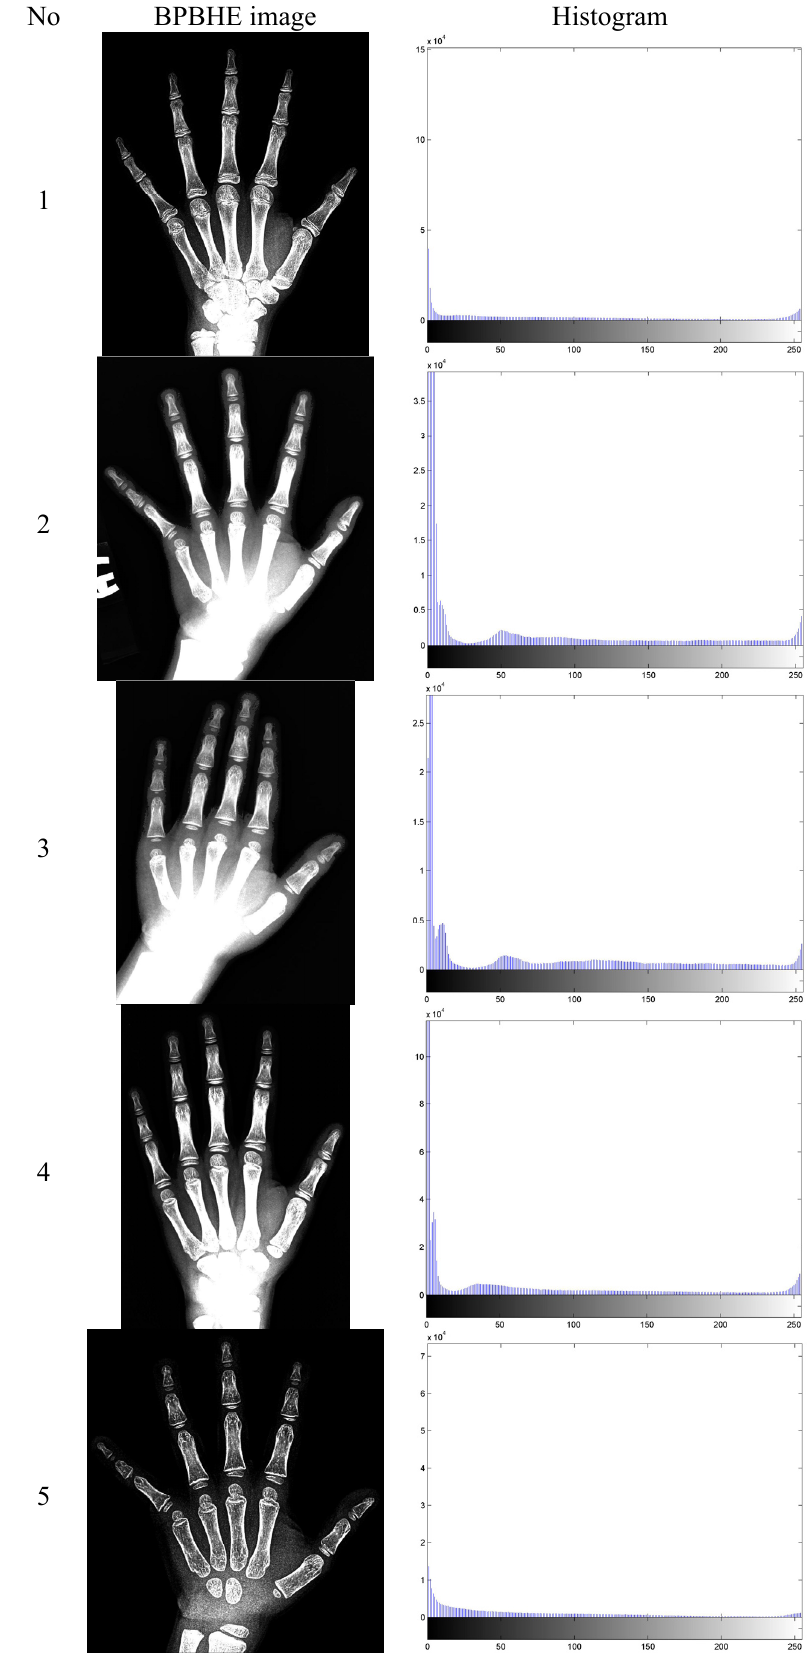
Figure 3. The output images and their histograms (brightness preserving bi-histogram equalization